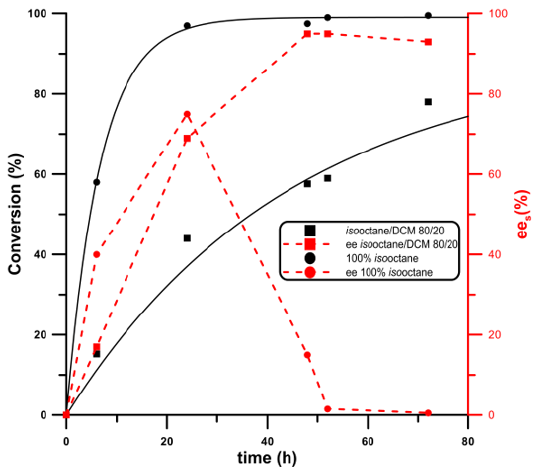
Figure 5. Kinetics of the esterification of rac - ibu profen with TEOF using pure isooctane and isooc- tane/DCM 80/20 ( v / v ).